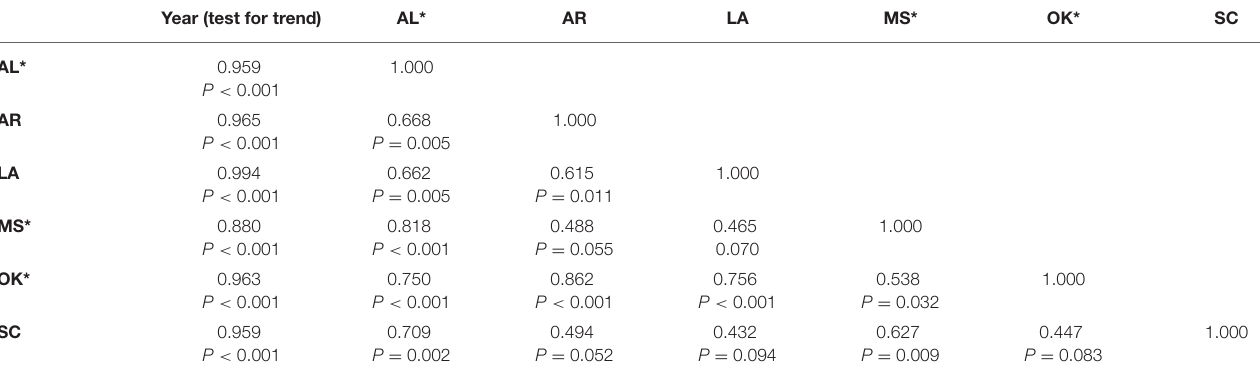
TABLE 2 | Annual oxycodone sales time series Spearman rank correlations between the six states, using second differences (2000–2017). Year (test for trend)